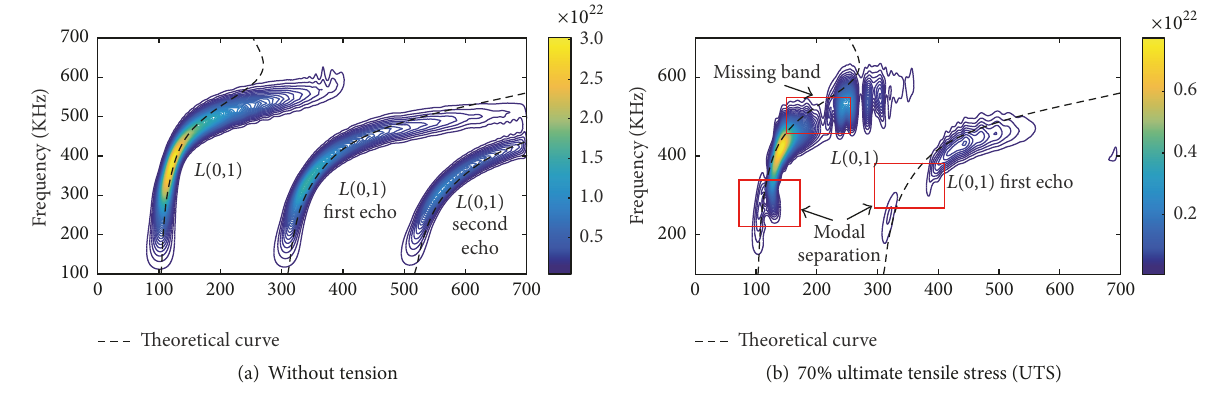
Figure 4: UGW time-frequency energy distribution.